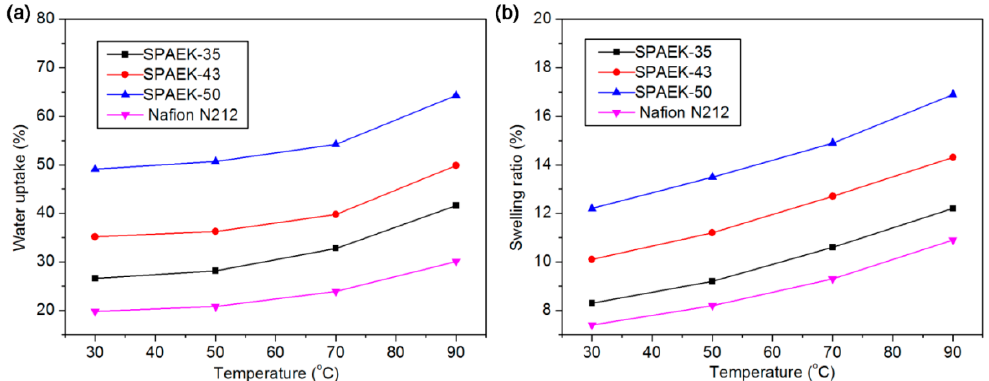
Figure 6. ( a ) Water uptake and ( b ) swelling ratio of SPAEKs and Nafion N212 as a function of temperature.